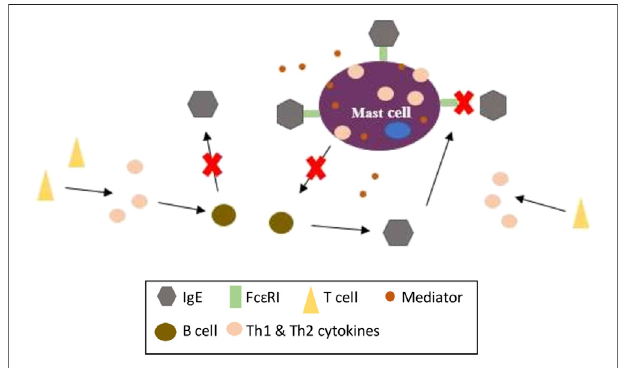
FIGURE 3 | The mechanism of actions of orally and topically administered herbs and their active constituents in murine model of AD.